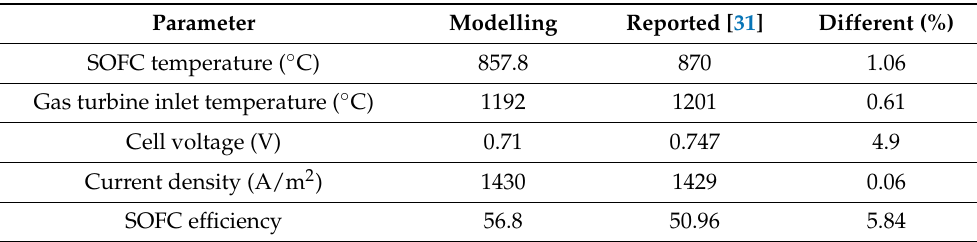
Table 6. Comparison of the simulation results of the proposed integrating model with the corre- sponding values obtained from the